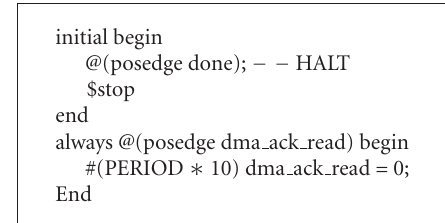
Algorithm 5: Generated Verilog code of two conditional break-